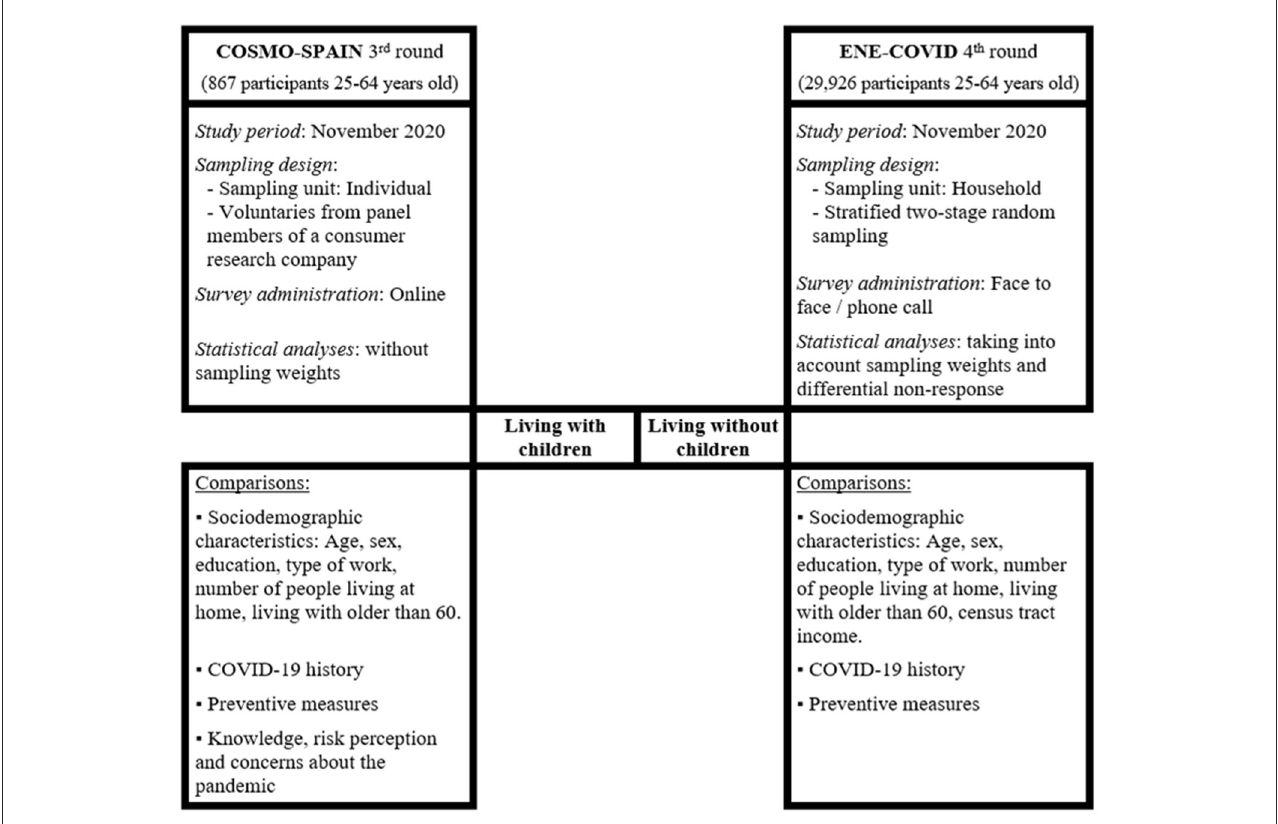
FIGURE1 Overview of the current study design based on data from COSMO-SPAIN and ENE-COVID, November